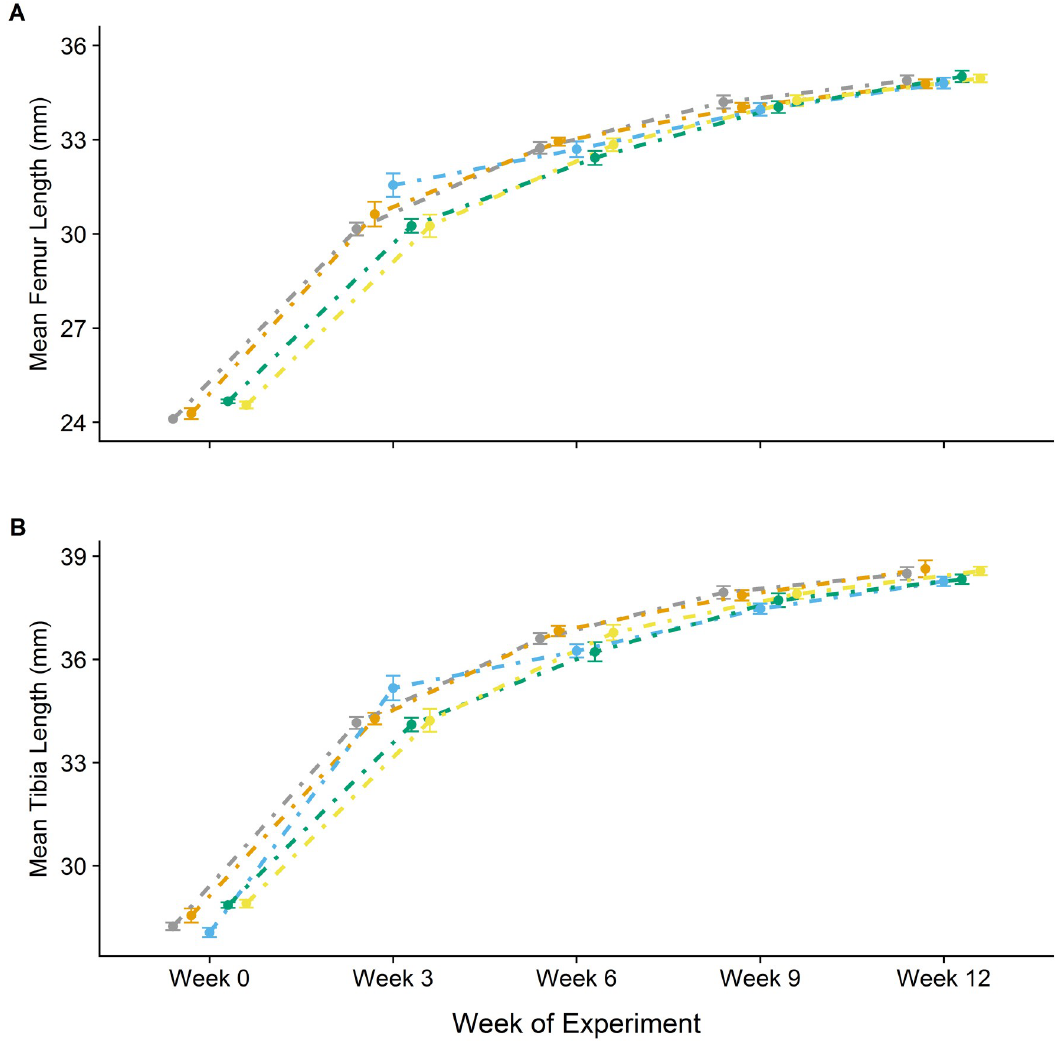
Fig 3. Mean lengths of the femur and tibia for each experimental group over the 12-week experiment. Line plots for the femur (A) and tibia (B) for each experimental group that were measured from each μ CT scan, every third week, over the 12-week experiment. The points represent the mean and the error bars represent the mean squared error for each